Question: Which visualization type does this figure use?
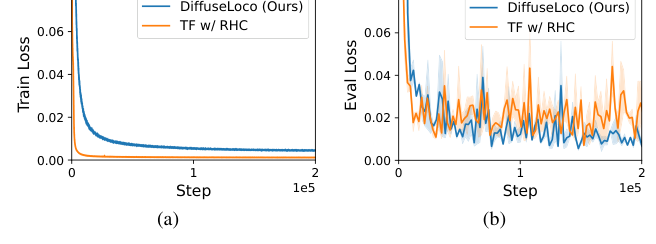
Answer: line